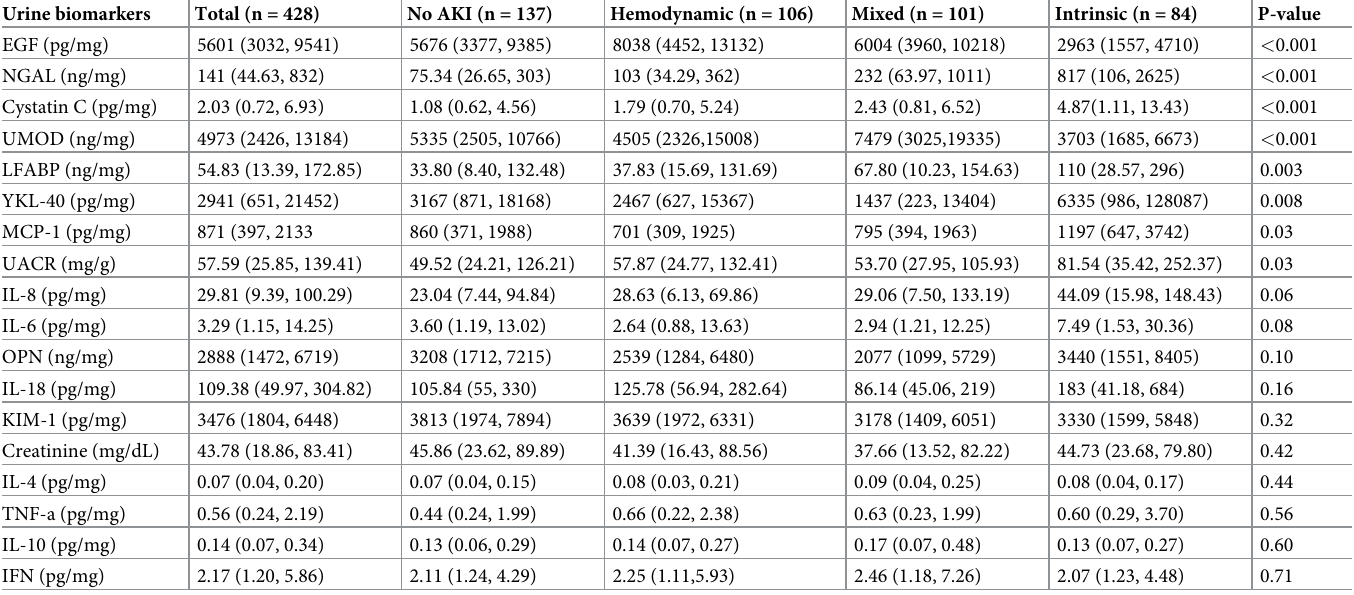
Table 3. Distribution of biomarkers among AKI phenotypes at anytime during